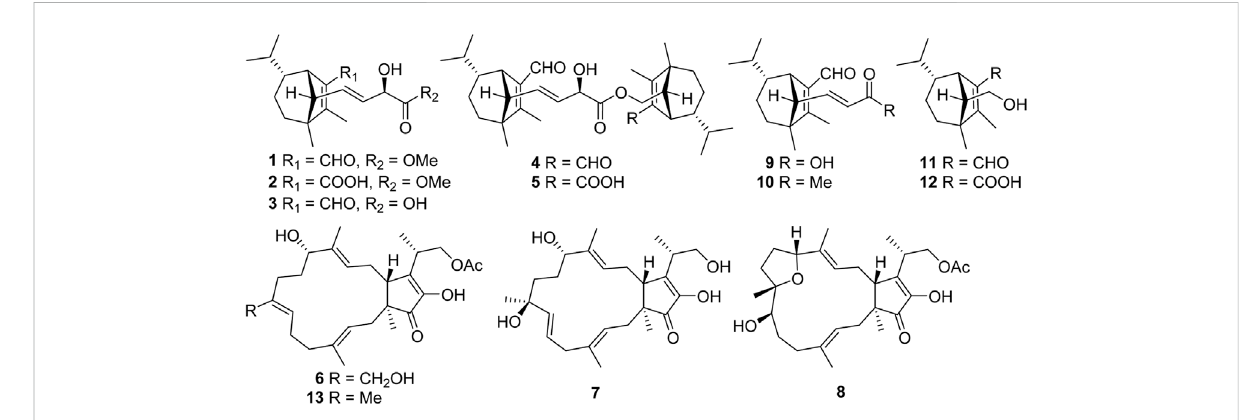
FIGURE 1 Structures of compounds 1 – 13